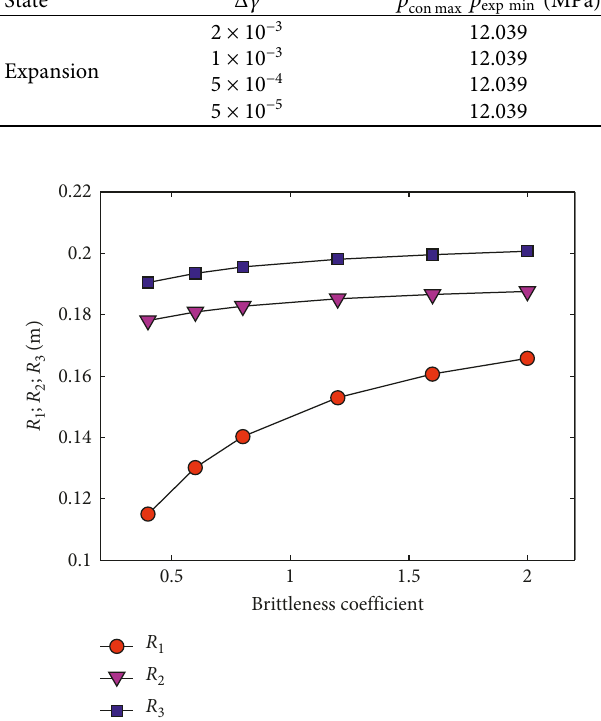
Figure 9: The radii of the postpeak failure zone under different brittleness coefficients.